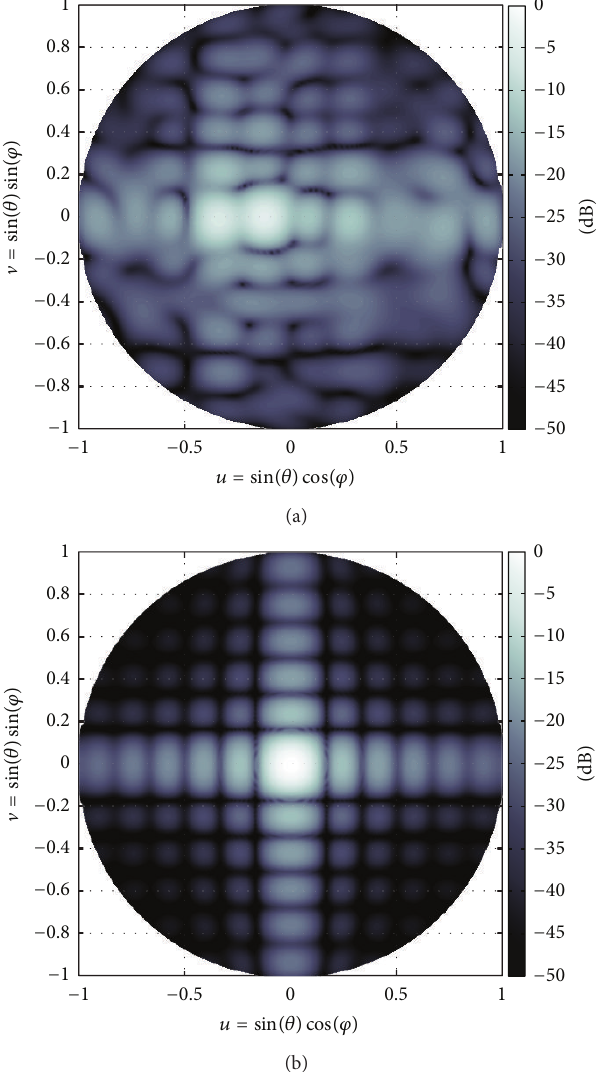
Figure 7: Simulated backscattering patterns under 𝑦 -polarized normal incidence at 4 GHz for (a) the nonuniform surface as instanceand(b)thenakedconductingsurface.Thefar-fieldintensity involved in this figure is the synthesized quantity √|𝐸 𝜃 | 2 + |𝐸 𝜑 | 2 . Both patterns are normalized to the specular far-filed intensity of the conducting surface and the values below − 50dB have all been